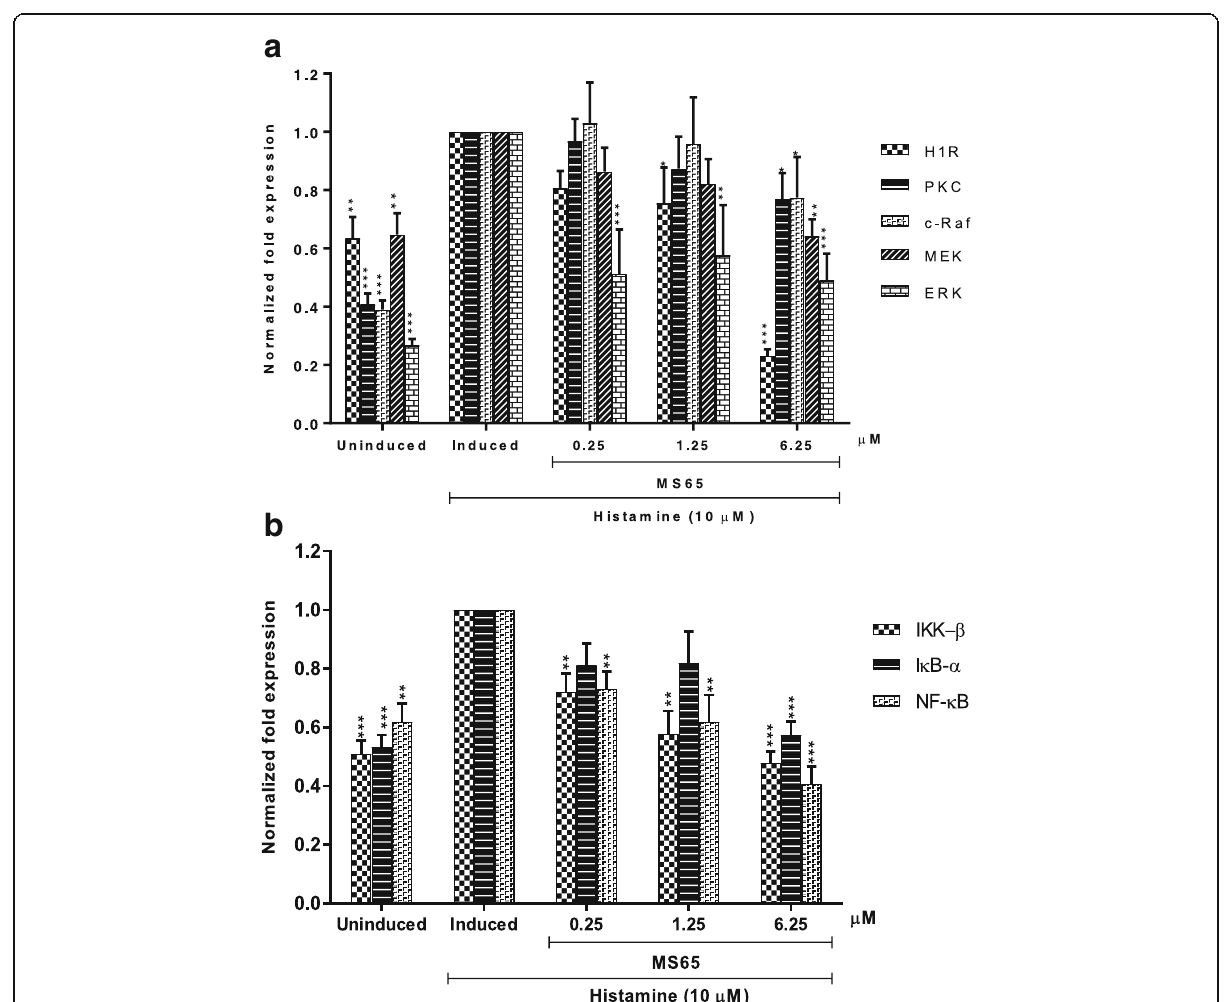
Fig. 4 Effects of MS65 on genes expression of ( a ) H1R, PKC, c-Raf, MEK, ERK and ( b ) IKK- β , I κ B- α , NF- κβ . Cells were treated with 10 μ M of histamine for 24 h in presence or absence of MS65. Total mRNA was extracted, and gene expression was analyzed by RT-qPCR. The fold expressions were normalized by GAPDH expression levels. Data are expressed as the mean ± S.E.M. of three separate experiments. Values of * P < 0.05, ** P < 0.01 and *** P < 0.001 were considered significantly different to histamine-induced control